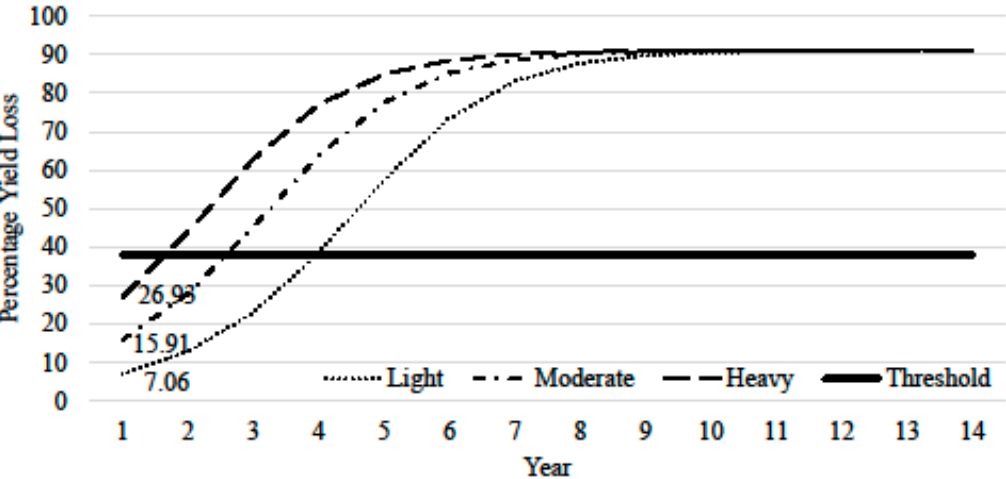
Figure 1. Estimated yield losses from light, moderate, and heavy initial red rice infestations.